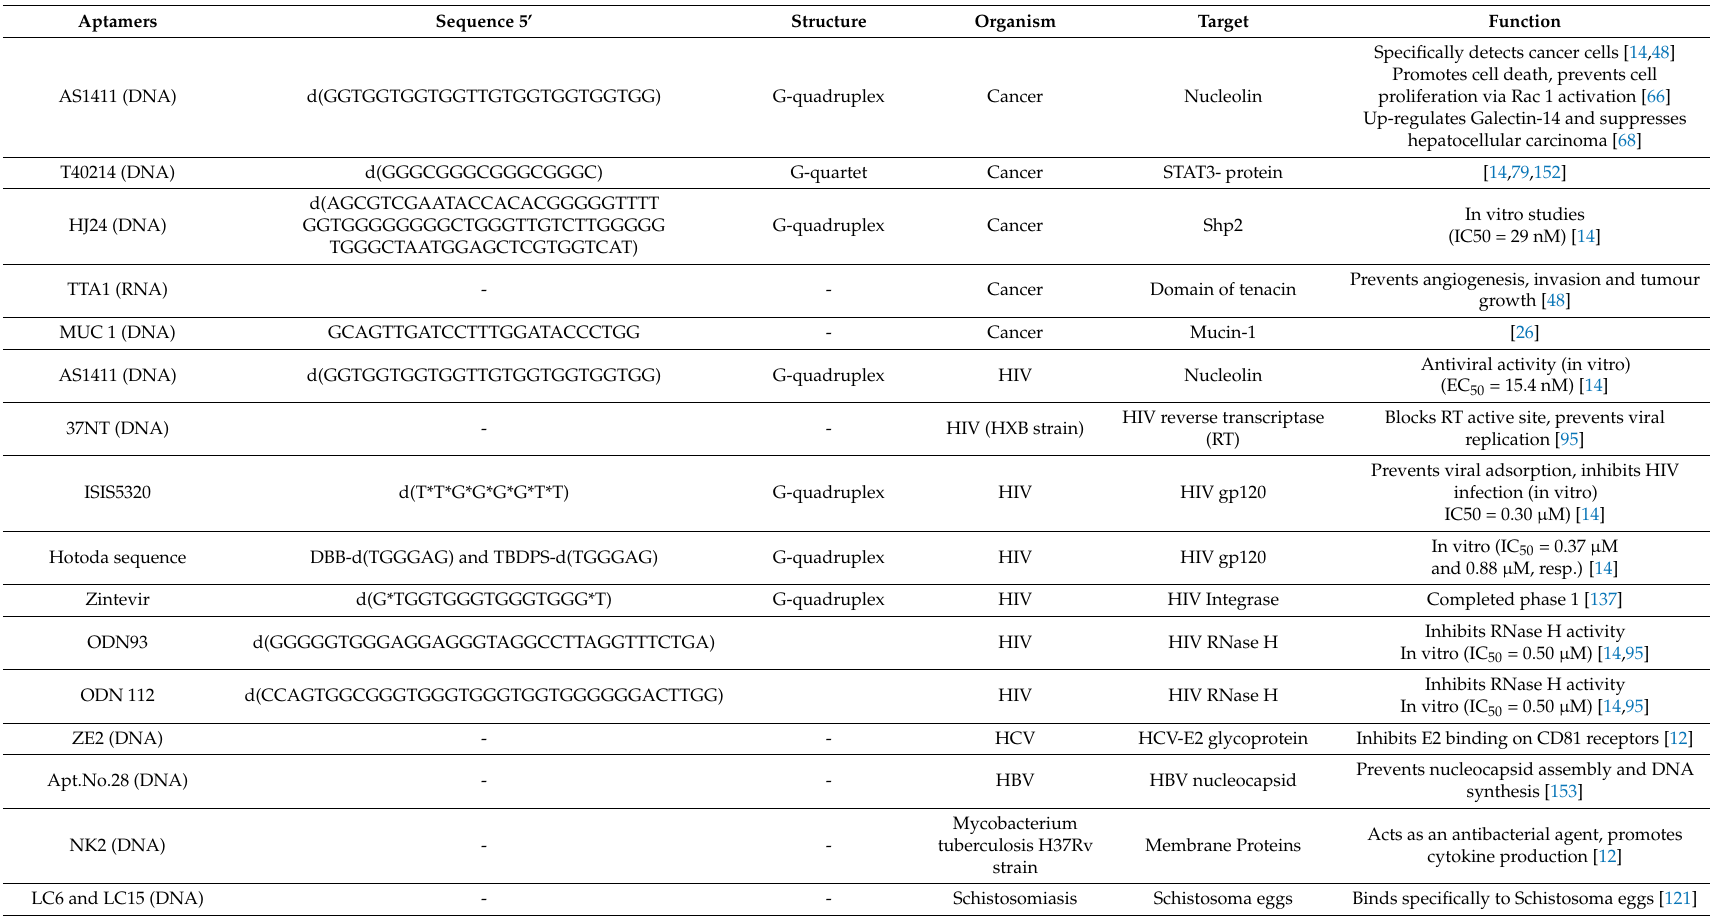
Table 2. Molecular Application of Aptamers in